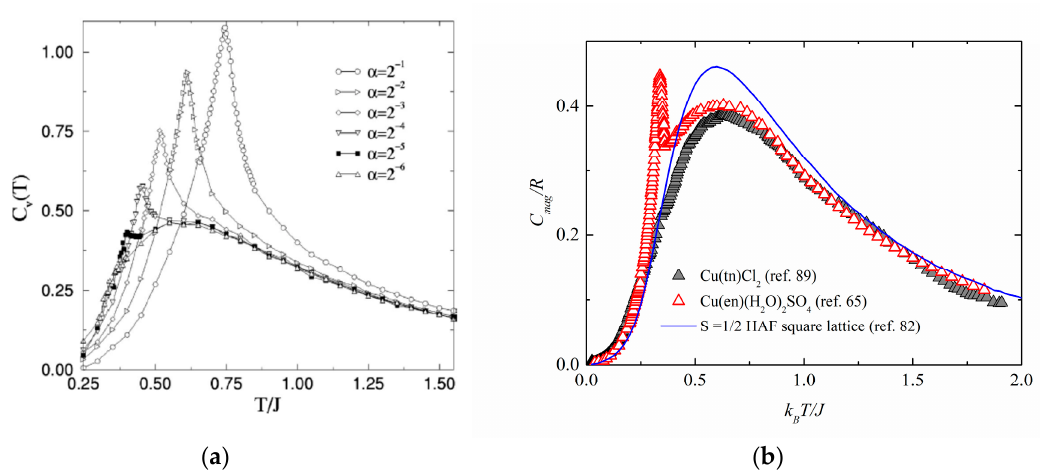
Figure 9. ( a ) The specific heat of the S = 1/2 HAF model on the spatially anisotropic simple cubic lattice with R = 1 within the layers. Quantum Monte Carlo calculations are performed over a wide temperature range for several different spatial anisotropies ( α = J” / J ). The system size is 48 × 48 × 12. The separation of the 3D ordering peak from the broad maximum arising from the 2D physics is clearly visible for α < 2 − 3 . (Reproduced with permission from reference [87]); ( b ) Temperature dependence of Cu(en)(H 2 O) 2 SO 4 ( J / k B = 2.8 K) and Cu(tn)Cl 2 ( J / k B = 3.1 K) magnetic specific heat compared with the theoretical prediction for the S = 1/2 HAF on the square lattice ( R = 1).